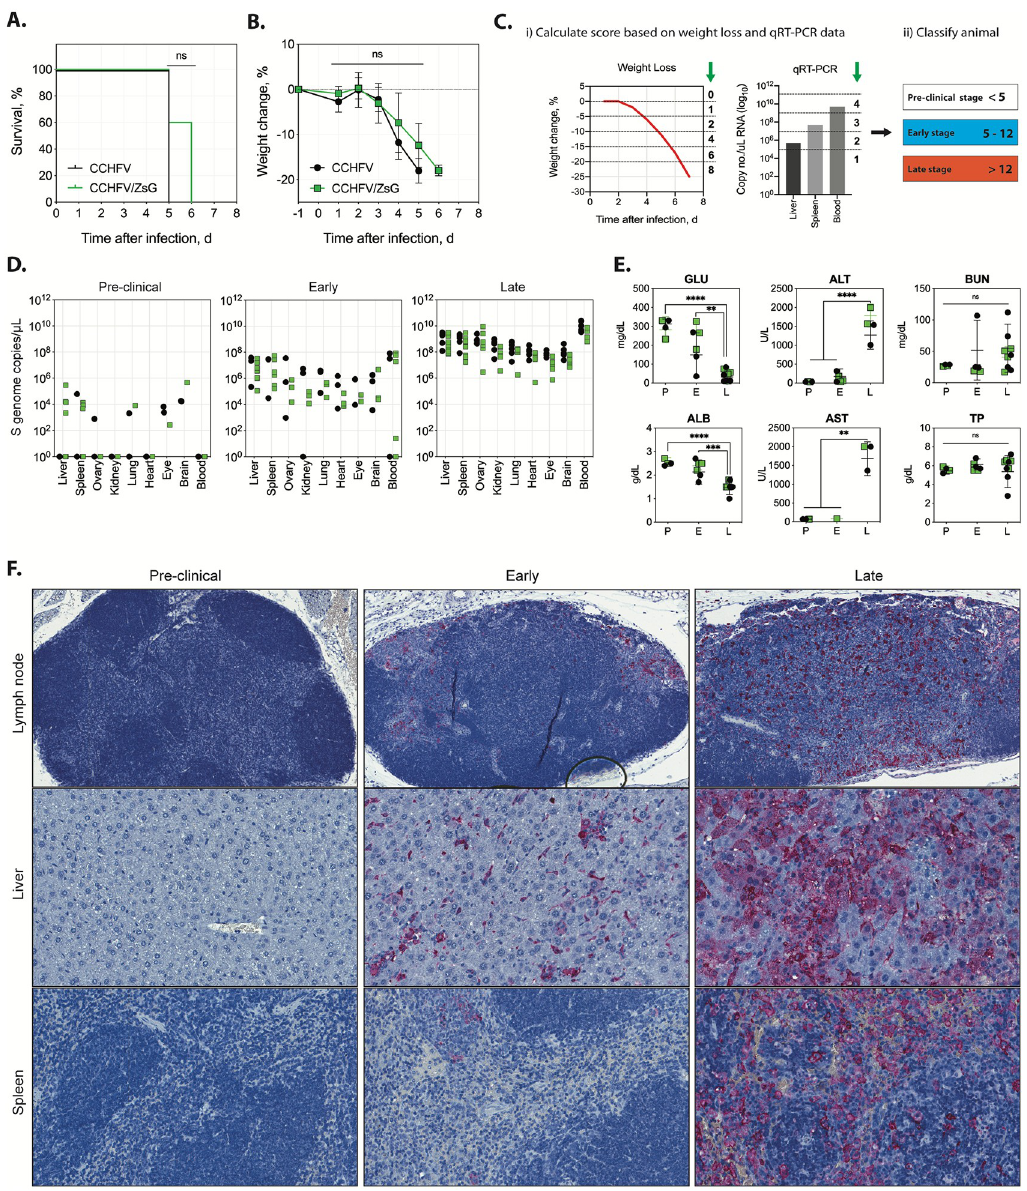
Fig 1. Comparative infections of wild-type CCHFV and reporter CCHFV/ZsG. (A) Survival and (B) weight change in Ifnar -/- mice inoculated subcutaneously with 100 TCID 50 recombinant wild-type CCHFV (CCHFV; black line with circles; n = 5) or recombinant CCHFV expressing ZsG (CCHFV/ZsG; green line with squares; n = 5). Lines represent mean weight change of all individuals on that day; error bars represent ± SD. ns = not significant. (C) Mice were classified into one of 3 disease stage groups based on weight loss and viral RNA levels in liver, spleen, and blood determined by qRT-PCR. Weight loss scoring criteria: 0 to -5% = 1; -6 to -10% = 2; -11 to 15% = 4; -16 to 20% = 6; > -20% = 8. Viral load scoring criteria (values are CCHFV S segment copies/ μ L): < 1 × 10 5 = 1; < 1 × 10 7 = 2; < 1 × 10 9 = 3; < 1 × 10 11 = 4. Classification scores: pre-clinical stage: < 5; early-stage disease: 5 to 12; late-stage disease: > 12. (D) Quantitative RT-PCR was performed based on primer and probe sets specific for CCHFV nucleoprotein (NP) on tissues taken from animals infected with CCHFV (black circles) or CCHFV/ZsG (green squares). Disease severity in animals was classified as either pre-clinical, early, or late using a scoring system based on weight loss and viral tissue load (S1 Table). (E) Clinical chemistry values performed on whole blood samples collected at the time of euthanasia in CCHFV- (black circles) or CCHFV/ZsG- (green squares) infected mice classified as being in pre-clinical (P), early (E), or late (L) stage of disease. Individual values are represented, with means and standard deviation shown. GLU, glucose; ALB, albumin; ALT, alanine aminotransferase; AST, aspartate aminotransferase; BUN, blood urea nitrogen; TP, total protein. ns = not significant; � p < 0 . 05 , �� p < 0 . 01 , ��� p < 0 . 001 , ���� p < 0 . 0001 . (F) CCHFV NP immunostaining demonstrated a progressive increase in antigen expression at pre-clinical, early-, and late-stage disease in draining (axillary) lymph node, liver, and spleen of